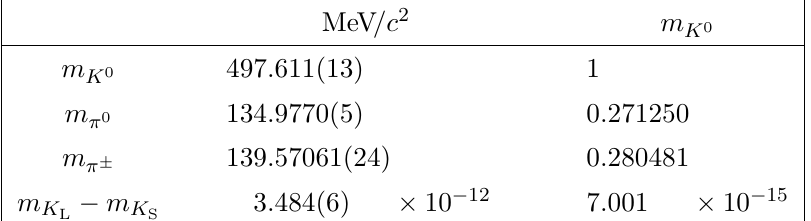
Table 1 . Values for the masses of the pions π 0 , π ± and the neutral kaon K 0 and the mass difference between K L and K S